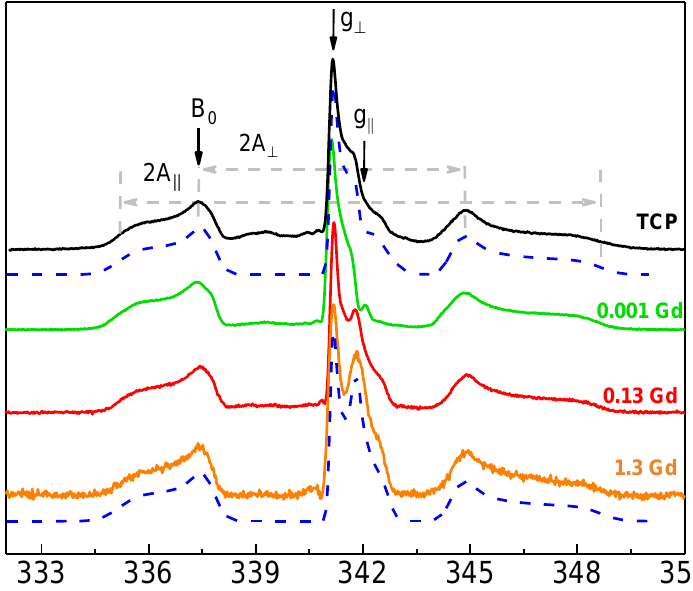
Figure 5. EPR spectra of irradiated TCP samples as a function of Gd 3+ concentration in pulsed mode. Dashed lines are the spectra simulations.